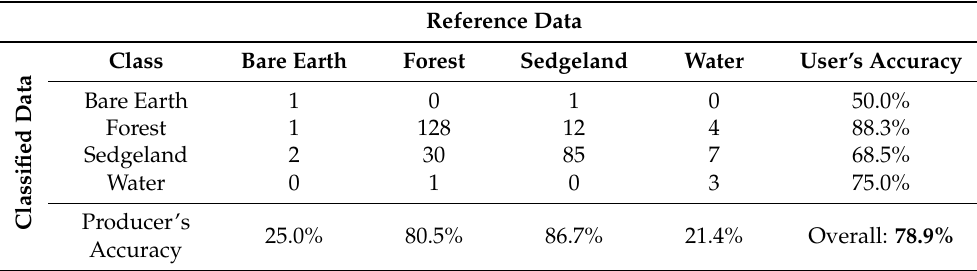
Table 6. Confusion matrix for LiDAR-only data stream describing vegetation classification.